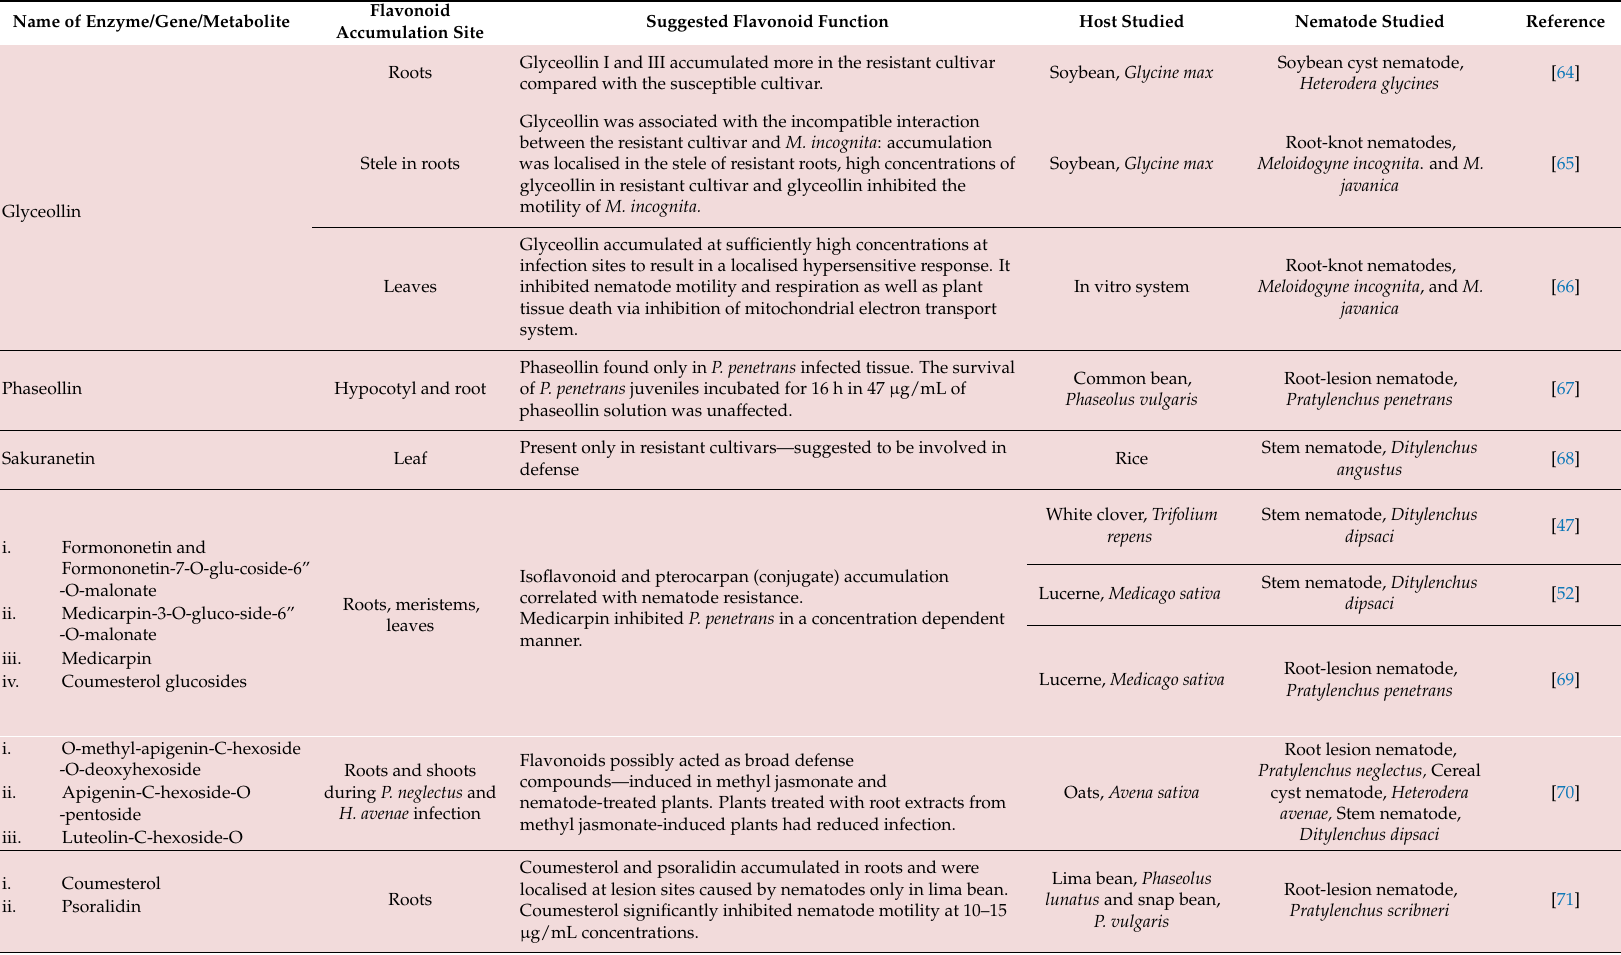
Table 1. Summary of the involvement of plant flavonoids in plant–nematode interactions. Rows in red indicate studies demonstrating the role of flavonoids in nematode defense responses, whereas rows in blue indicate studies demonstrating the role of flavonoids in nematode feeding sites and rows in purple indicate studies intersecting across both